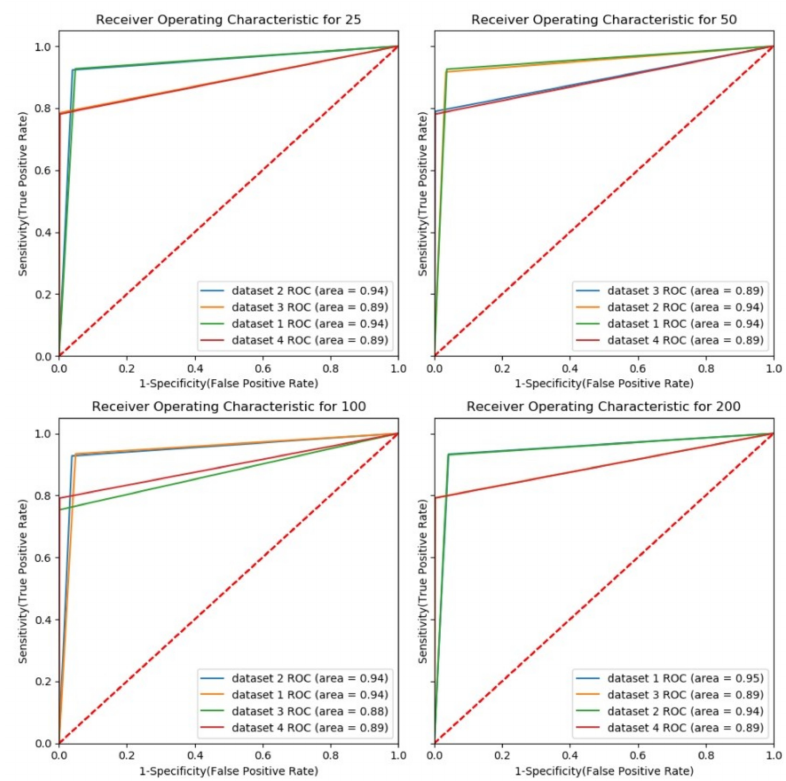
Figure 9. Roc curve for CNN model results for each dataset as a first component in our ensemble method.